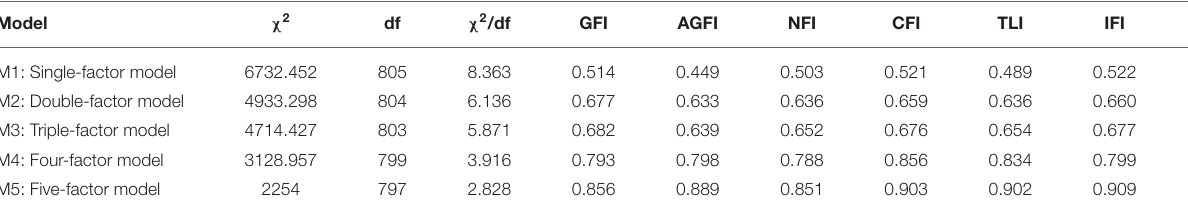
TABLE 7 | Major fitting degree indices of URSCC.